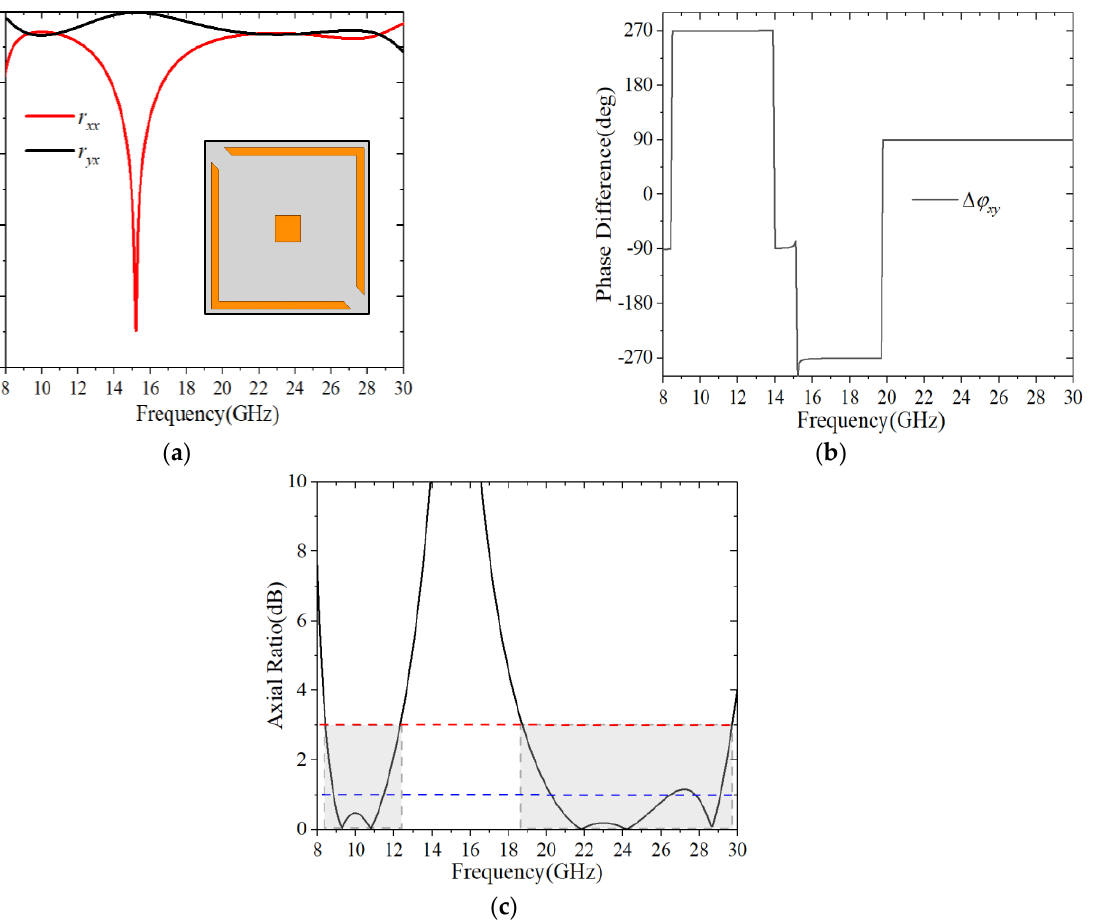
Figure 3. Simulation results for normal x -polarized incidence. ( a ) Amplitude; ( b ) Phase difference; ( c ) Axial